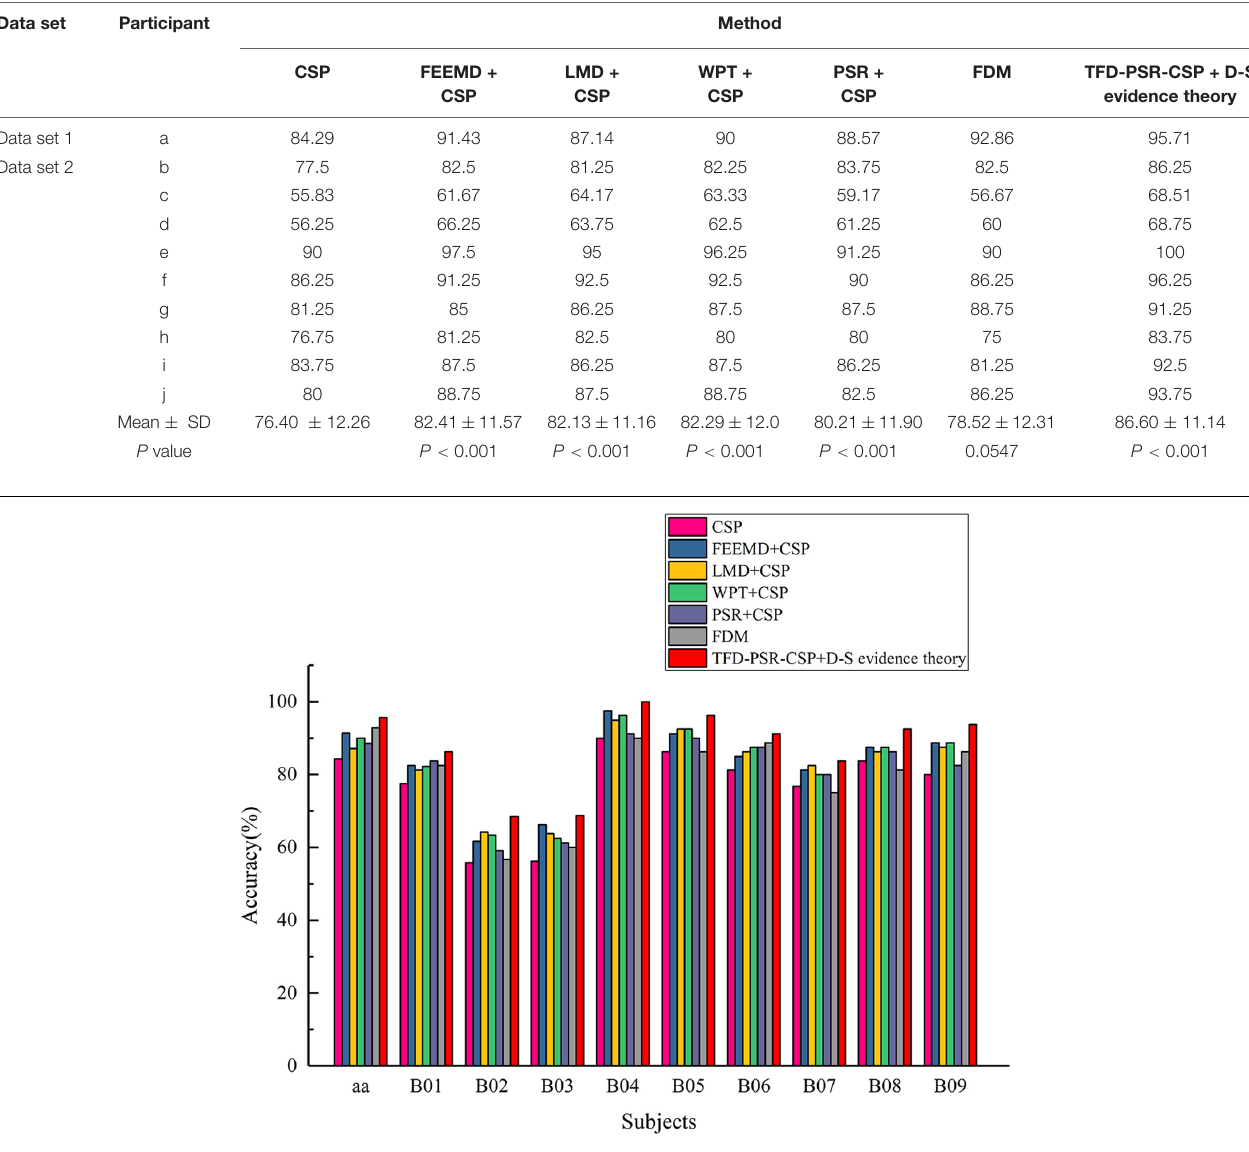
FIGURE 3 | Classification accuracy of all participants in data set 1 and data set